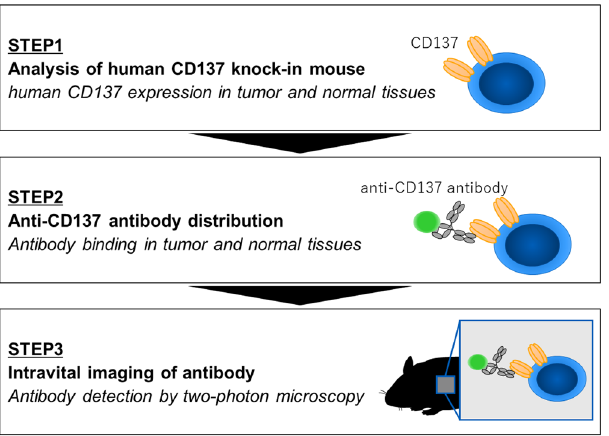
Figure 1. Research strategy for detection of antibody binding in tissues by two-photon microscopy. In Step 1, human CD137 expression was examined in tumor-bearing hCD137-KI mice. In Step 2, a fluorescently labeled anti-CD137 antibody was administered to hCD137-KI mice. Finally, antibody-binding cells in the tumor and spleen were detected by two-photon microscopy in Step 3.